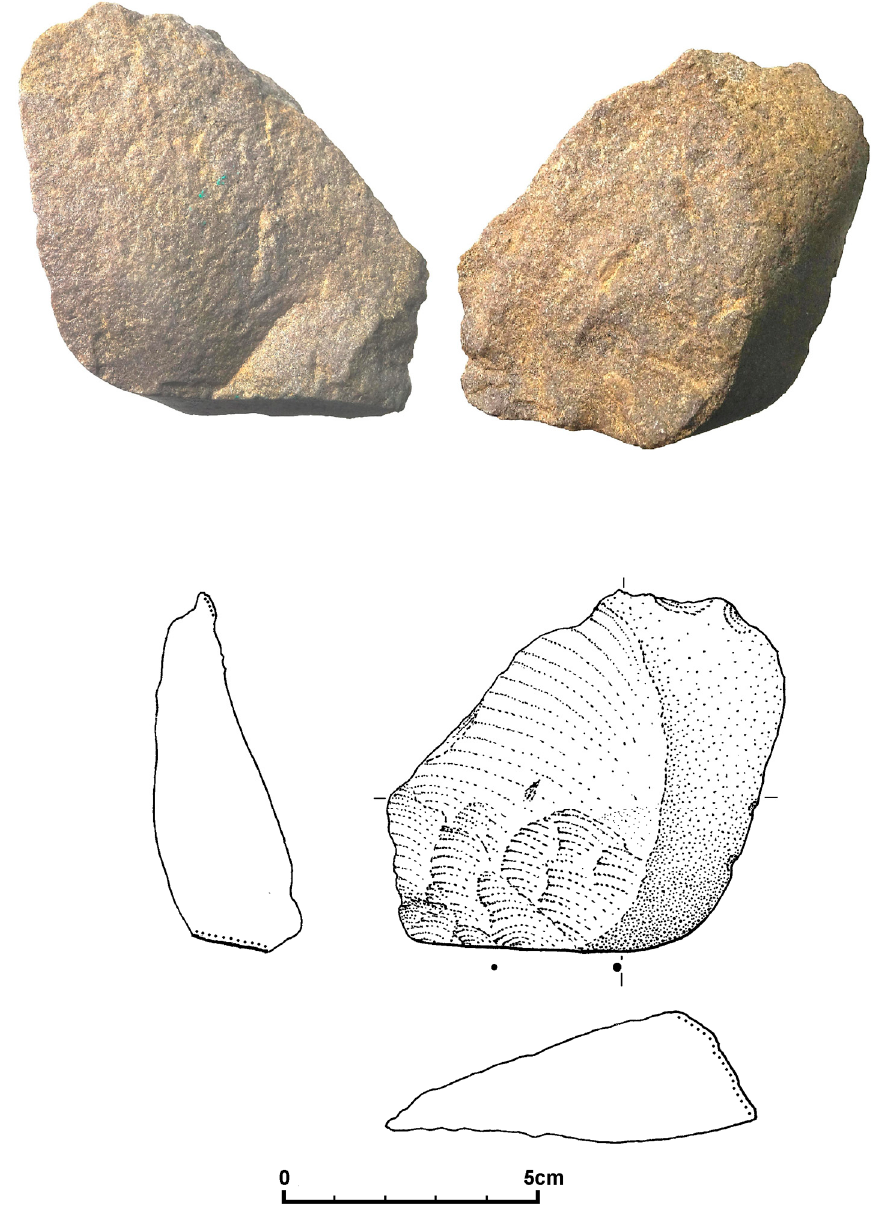
Figure 6. Münster-Sarmsheim. Quartzite flake in situ out of the 200 m tNa 5.1 terrace on the Kesslers-Berg gravel pit. (Photo: S. Stoll, drawing: L. Fiedler.).